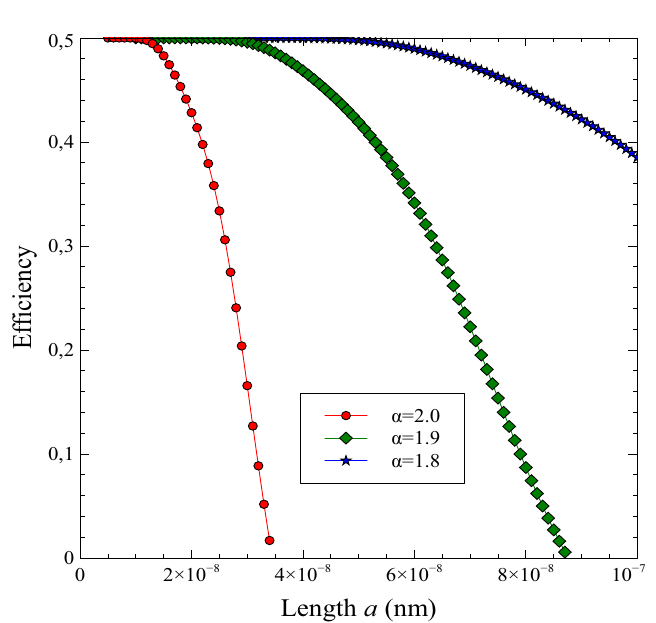
31 23 9.11 10 1.380649 10 kg, k B − − = × = ×